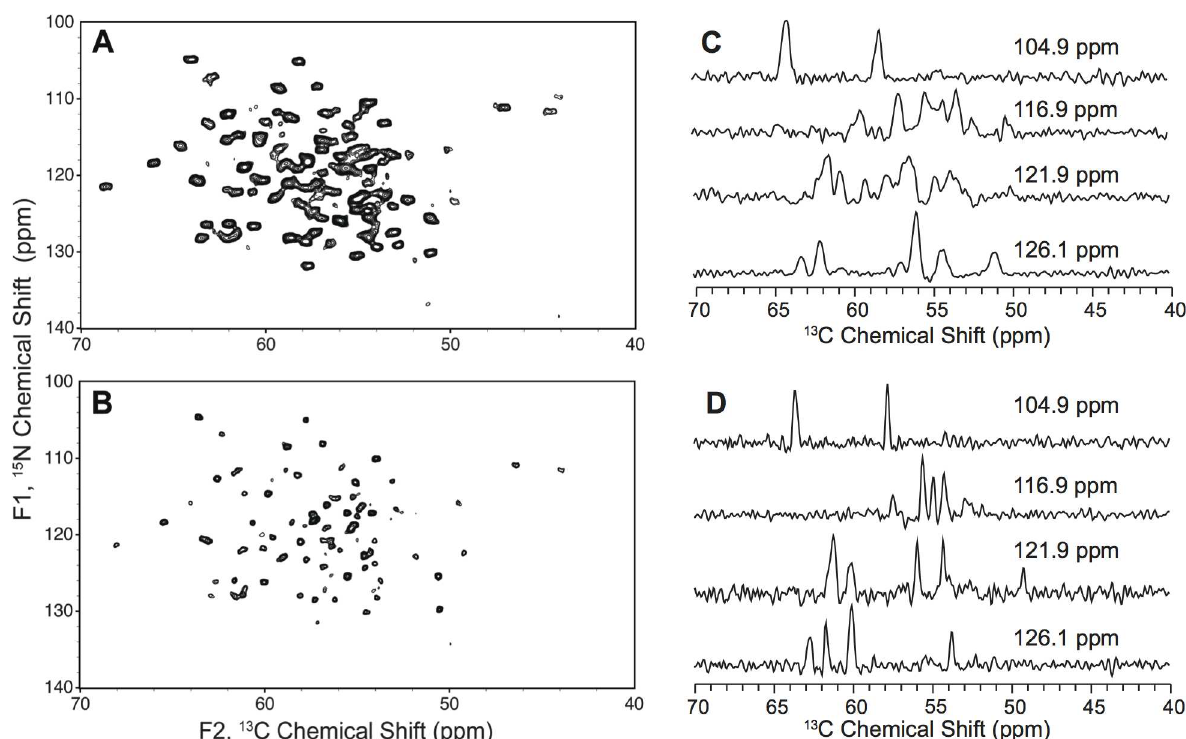
Fig 4. Solid-state 15 N- 13 CA correlation spectra of uniform and glycerol labeled sTF. (A) 15 N- 13 CA correlationspectrum of ~30 mg of uniform 13 C, 15 N ammonium sulfate-precipitatedsTF with 5 mM Cu-EDTA. The spectrum was acquired for 3 hours and 20 minutes with an acquisition time of 25 ms. (B) 15 N- 13 CA correlationspectrum of ~25 mg of 2- 13 C glycerol, 2 H, 15 N ammoniumsulfate-precipitated sTF with 5 mM Cu-EDTA. The spectrum was acquired for 3 hours with an acquisition time of 30 ms. Both spectra were collected at 750 MHz ( 1 H frequency) at a variabletemperatureset point of -5˚C with a MAS rate of 12.5 kHz. Both spectra were processedwith 10 Hz of Lorentzian-to-Gaussian line broadening in each dimension, sine bell apodization, and zero filled 8192 points in the direct (F1) dimension and 2048 in the indirect (F2) dimension with contours drawn at 6 times the noise floor. (C) 13 C 1D slices extracted from the 15 N- 13 CA 2D spectrum of uniform 13 C- 15 N ammoniumsulfate-precipitated sTF shown in A. The corresponding 15 N chemicalshifts in the indirect dimensionare indicated.(D) 13 C 1D slices extracted from the 15 N- 13 CA 2D spectrum of 2- 13 C glycerol, 2 H, 15 N ammoniumsulfate- precipitatedsTF shown in B. The corresponding 15 N chemical shifts in the indirect dimension are indicated.